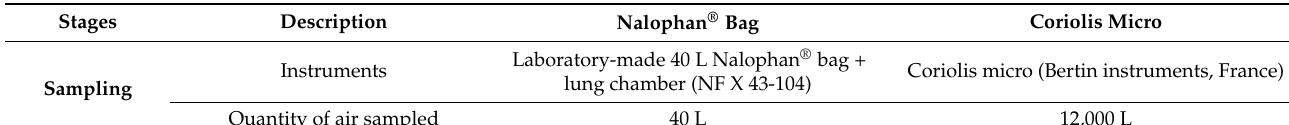
Figure 6. Distribution of sampling points around Thau lagoon. Table 2. Methods collection and analysis used for air